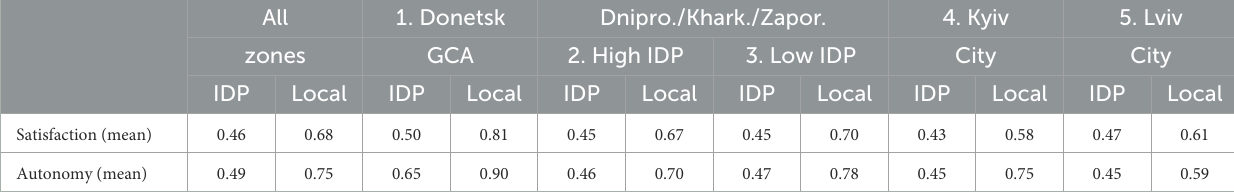
TABLE 7 Housing satisfaction and autonomy by zone. All 1.